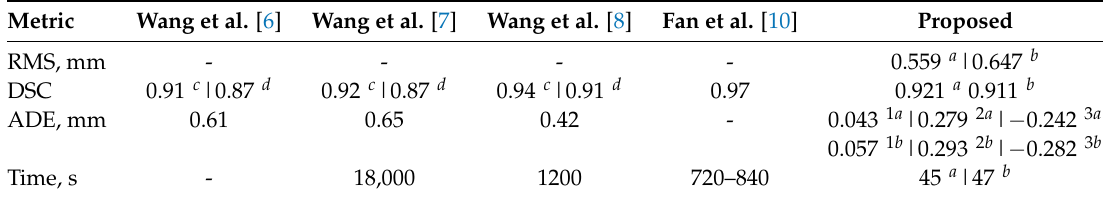
Table 2. The comparison of different automatic methods by 4